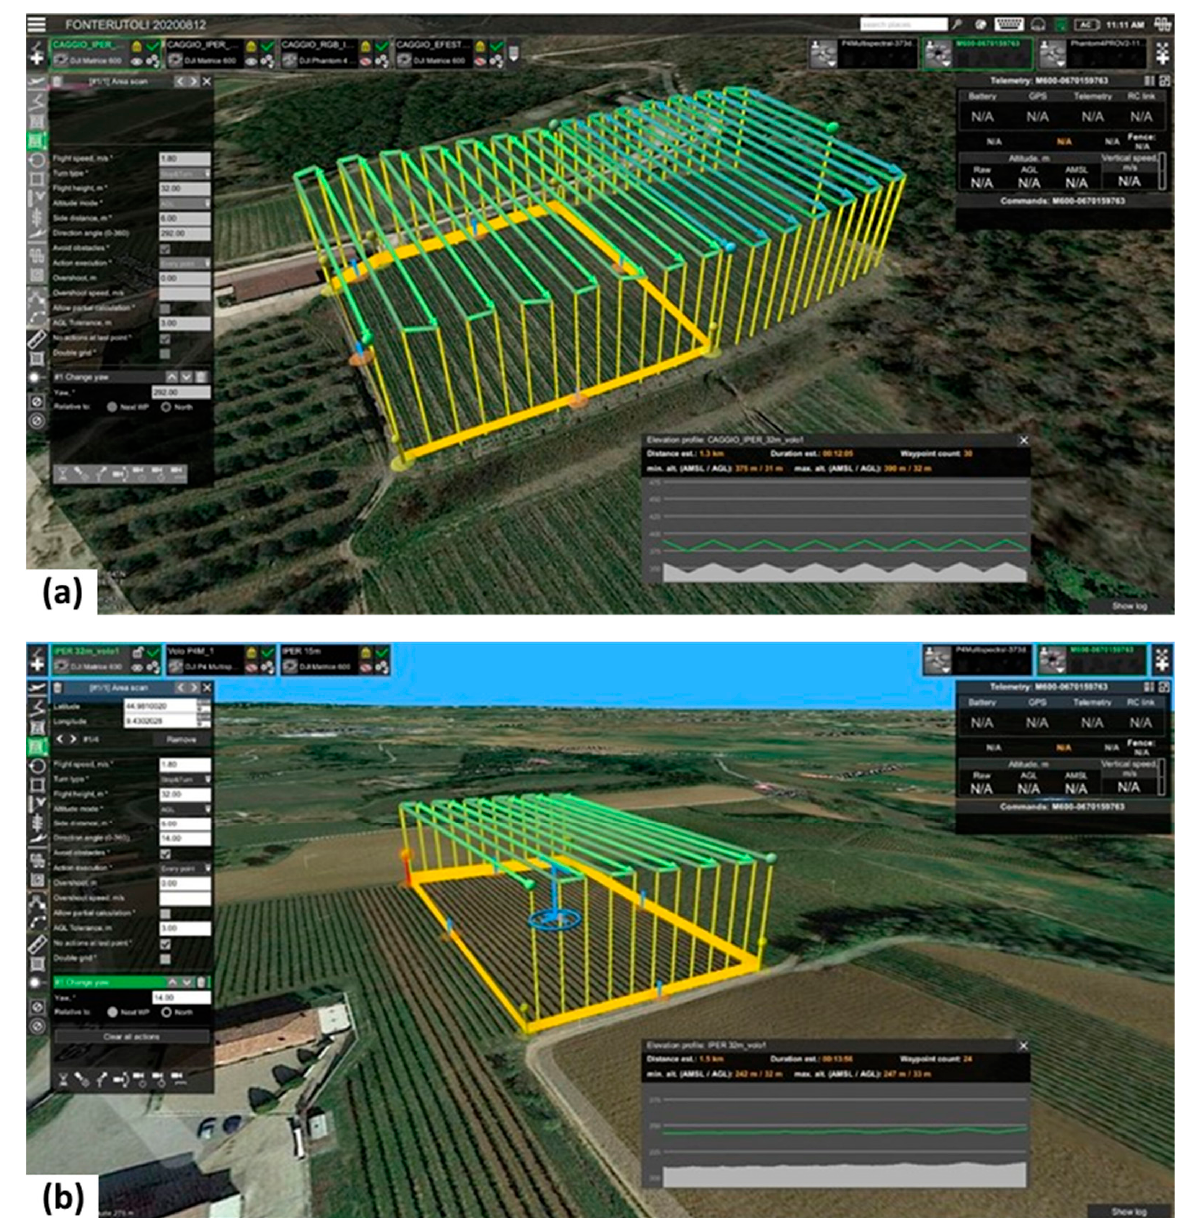
Figure 16. Flight plans, parameters and mission area for the Italian study areas: ( a ) Piacenza test area; and ( b ) Chianti test area.